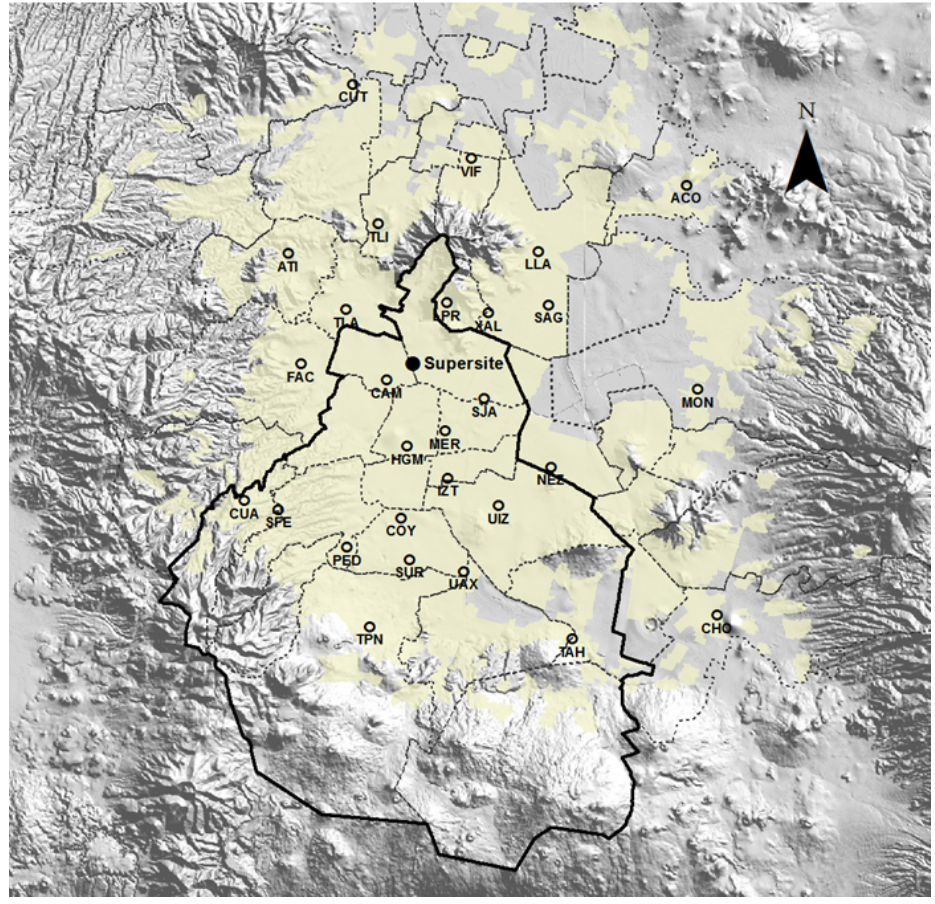
Figure 1. This map of the metropolitan area of Mexico City shows the locations of the RAMA air quality monitoring stations and the location of the supersite where the measurements were made for this paper. Map courtesy of the Mexico City government (http://www.aire.df.gob.